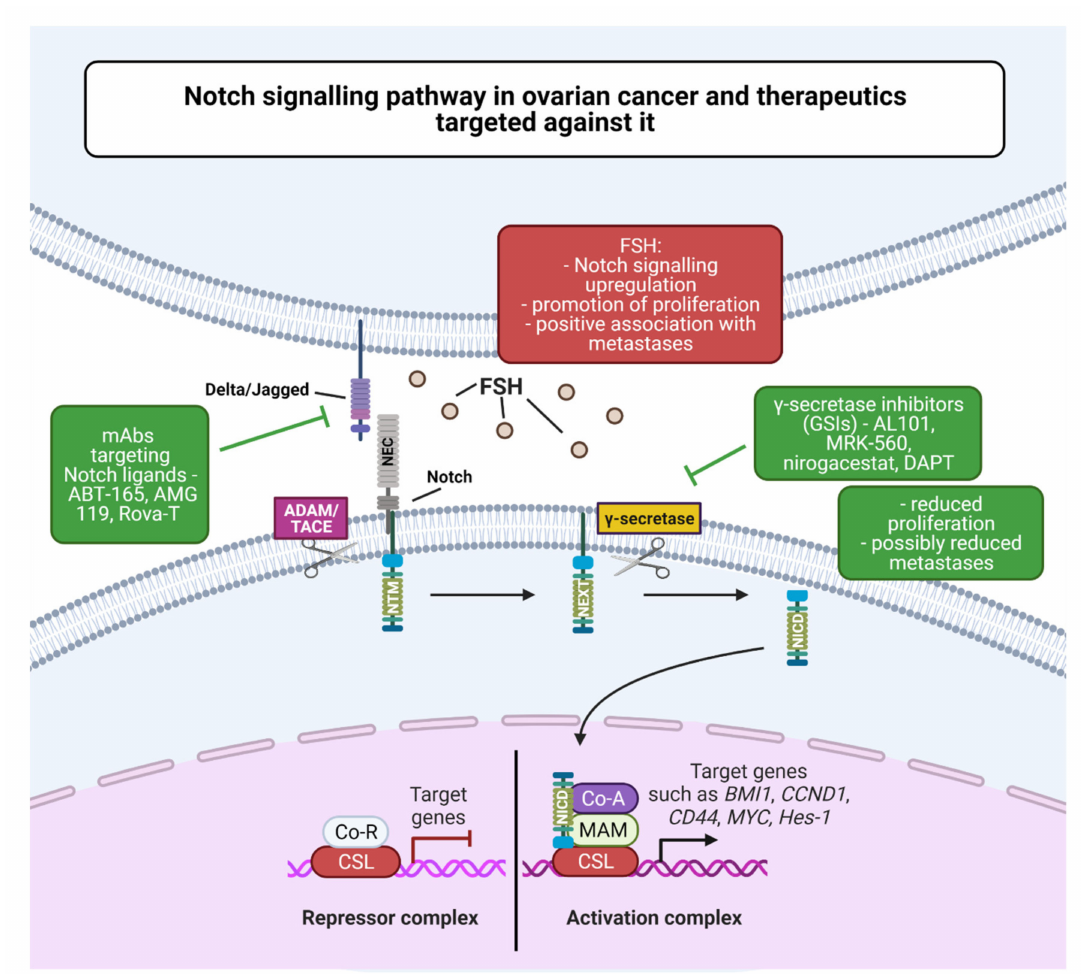
Figure 4. Notch signaling pathway in ovarian cancer and therapeutics targeted against it. Abbreviations: ADAM/TACE—a disintegrin and metalloproteinase/tumor necrosis factor-alpha converting enzyme; BMI1—B lymphoma Mo-MLV insertion region 1 homolog, CCND1—cyclin D1; CD44—CD44 Molecule (Indian Blood Group); Co-A—co-activator; Co-R—co- repressor; CSL—CBF1, Suppressor of Hairless, Lag-1; FSH—follicle-stimulating hormone; Hes-1—hairy and enhancer of split-1; mAbs—monoclonal antibodies; MAM—mastermind; MYC—MYC proto-oncogene, bHLH transcription factor; NEC—Notch extracellular subunit; NEXT—Notch extracellular truncation; NICD—Notch intracellular domain; NTM— Notch transmembrane subunit (created with